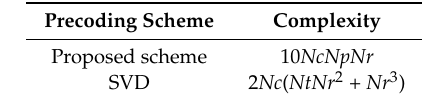
Table 1. Computation complexity.